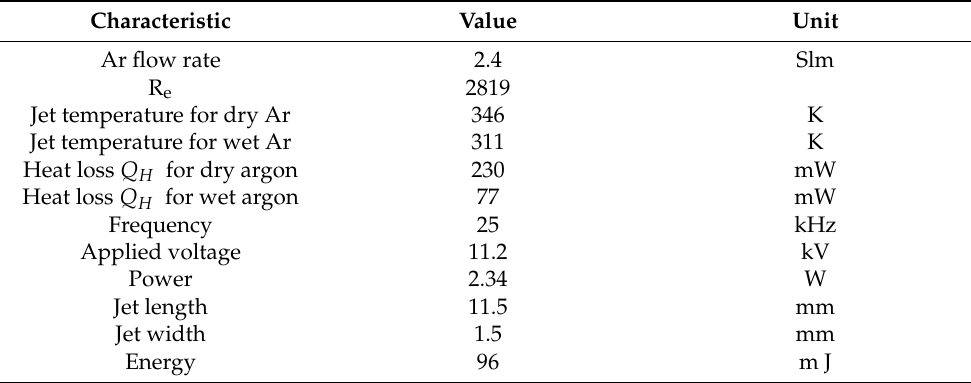
Table 1. Values of maximum laminar flow mode characteristics for argon discharge.